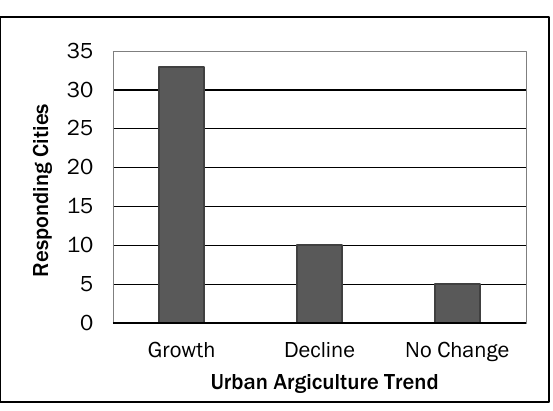
Figure 2. Reported Urban Agriculture Growth and